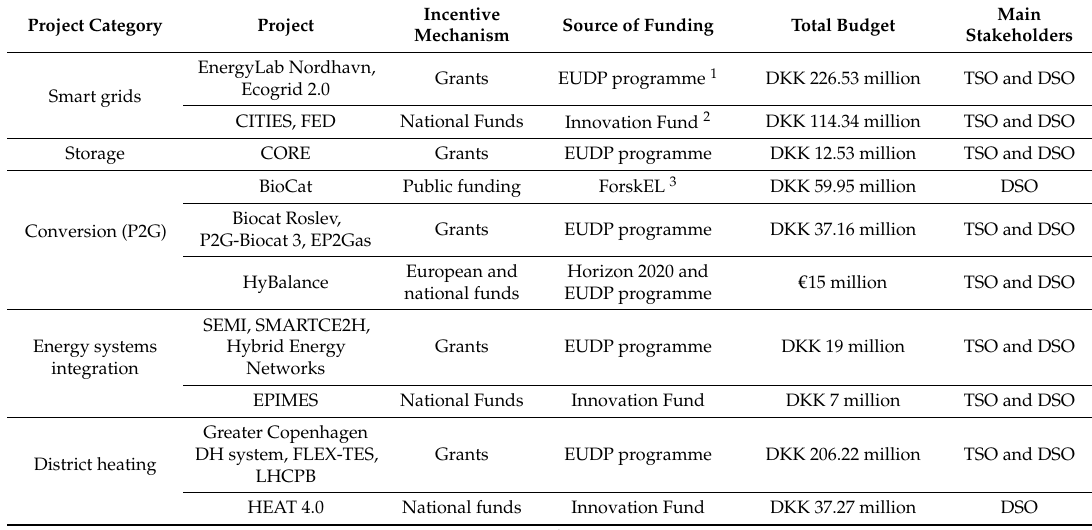
Table 5. Overview of network innovation projects in